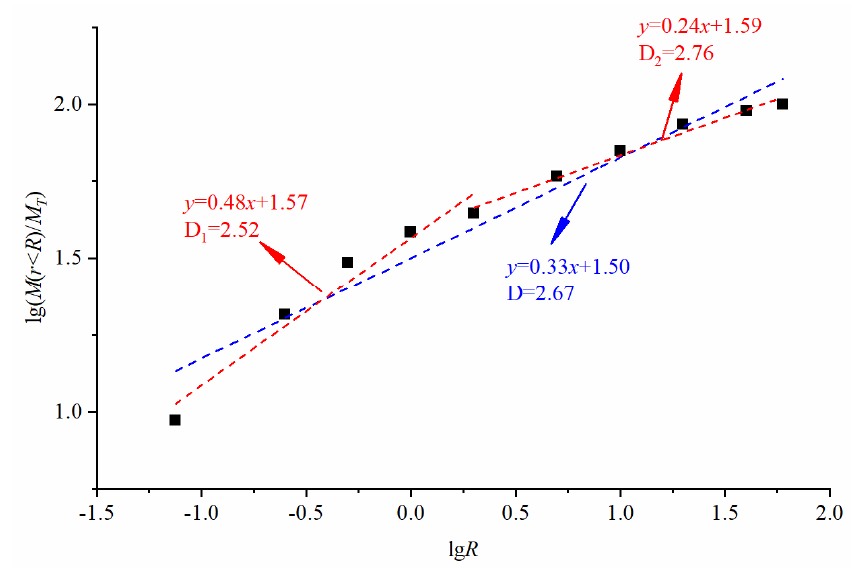
Figure 3. Fractal analysis of SRM sample.